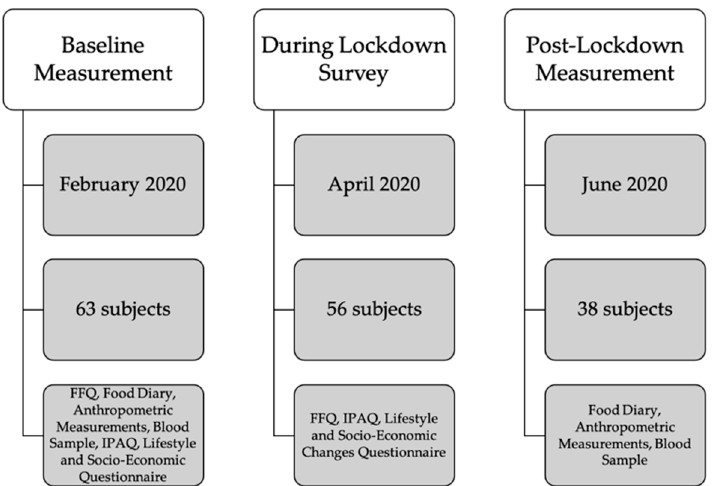
Figure 1. Study Design. FFQ—Food Frequency Questionnaire; IPAQ—International Physical Activity Questionnaire.